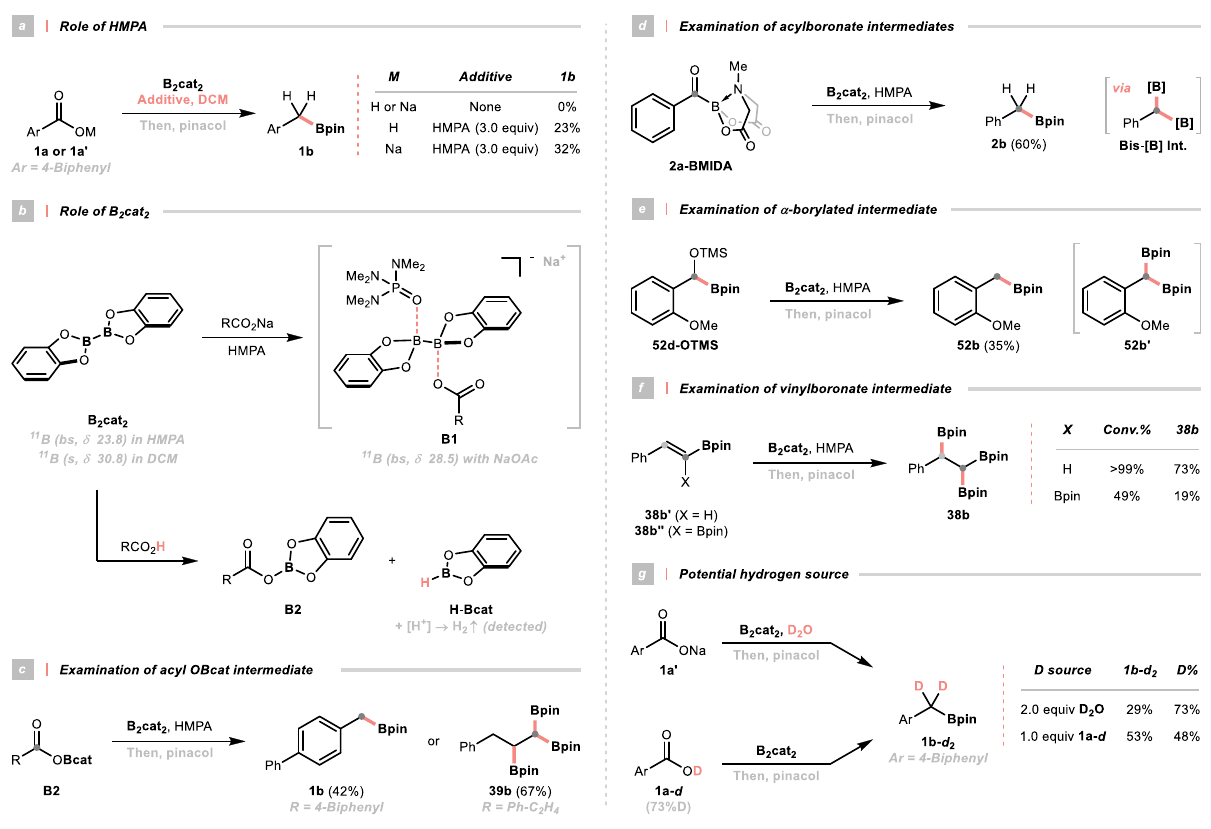
Fig. 4 Key mechanistic discoveries. For detailed conditions, see Supplementary Information including a Role of HMPA; b Role of B 2 cat 2 ; c Examination of acyl OBcat intermediate; d Examination of acylboronate intermediate; e Examination of α -borylated intermediate; f Examination of vinylboronate intermediate; g Potential hydrogen source. Unless otherwise speci fi ed, the deoxygenative borylation were performed under optimal conditions and yields were determined by NMR. DCM dichloromethane, BMIDA boronic acid methyliminodiacetic ester, TMS